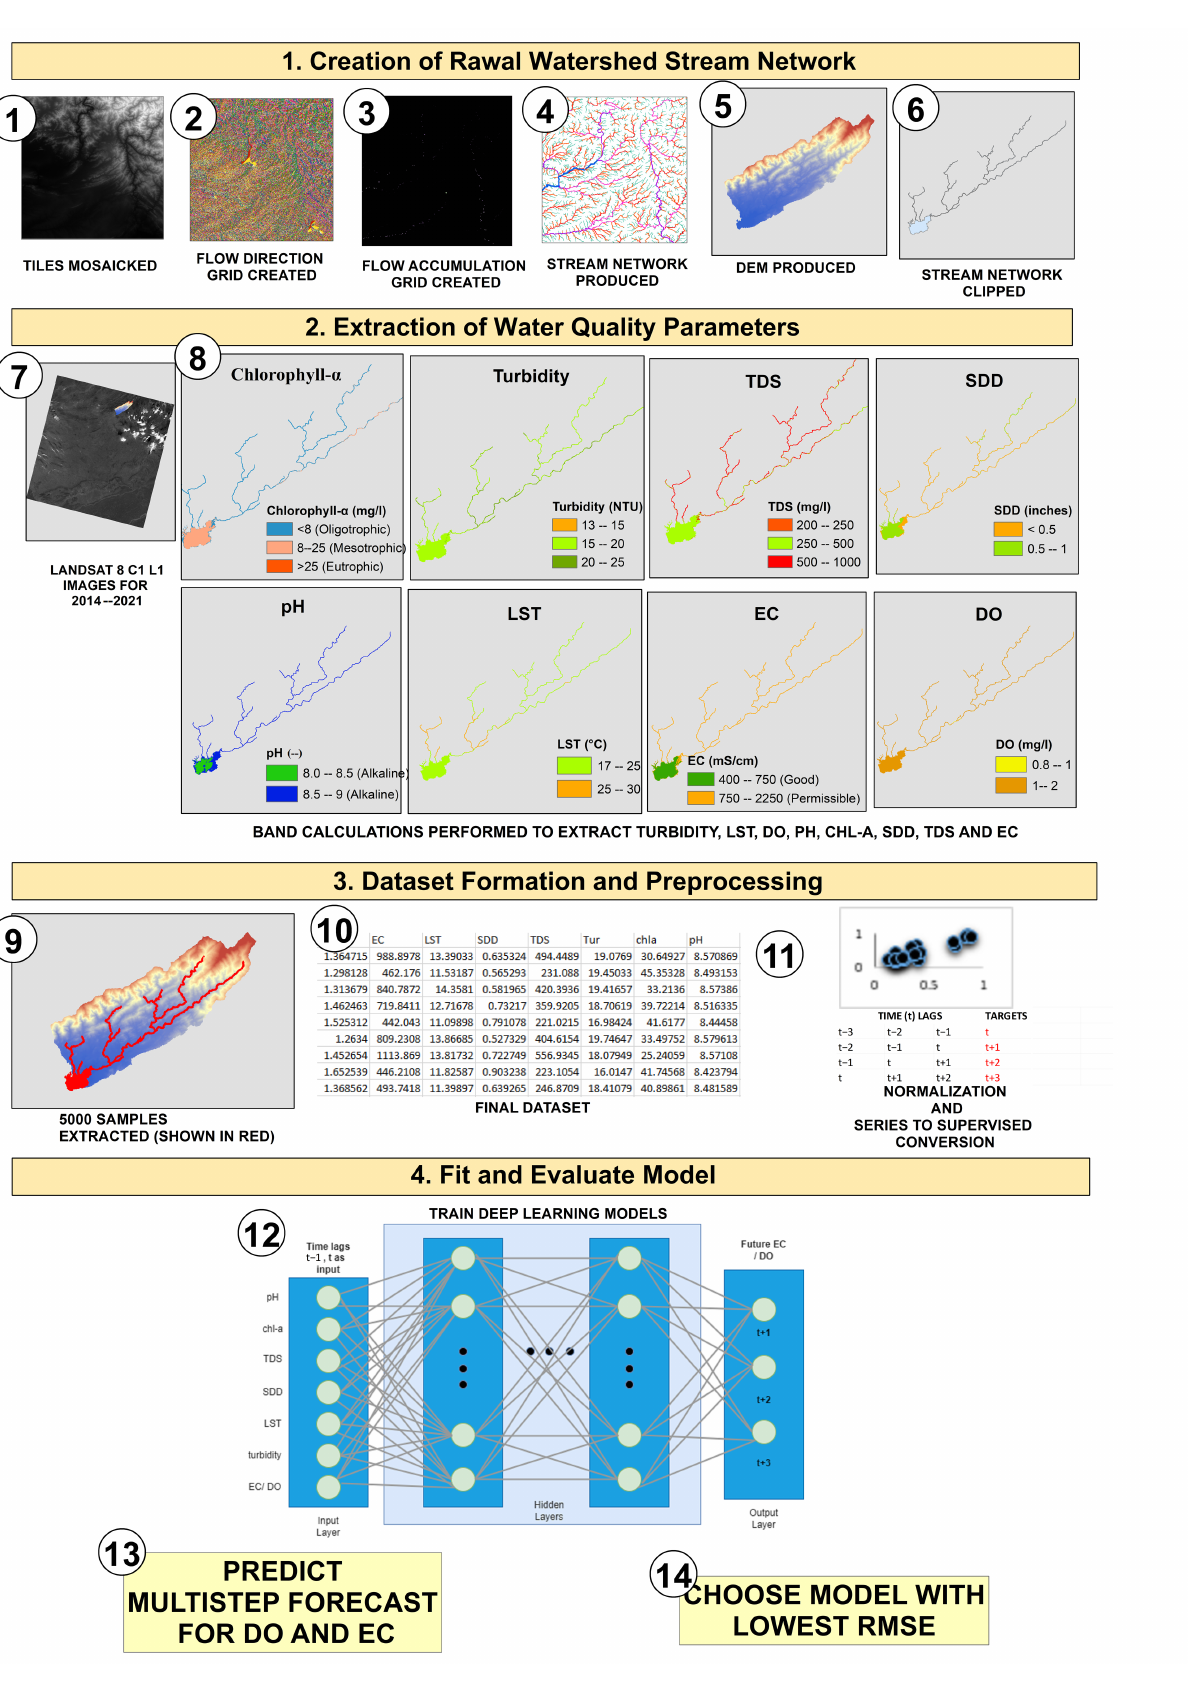
Figure 1. Steps proposed for estimating multi–step forecasts of EC and DO parameters for the study area of the Rawal